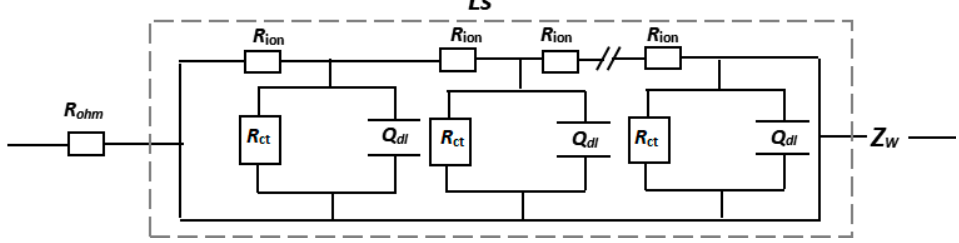
Figure 8. RC circuit suggested for symmetric cells for NCM523 or graphite.